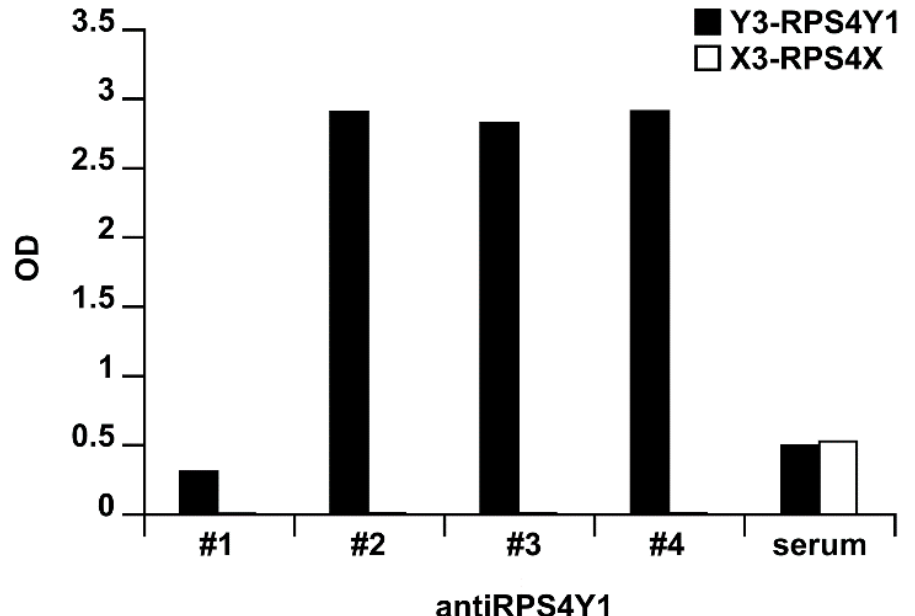
capture peptides and 2 µ g/mL of antiRPS4Y1 antibodies #1, #2, #3, #4 or mouse serum